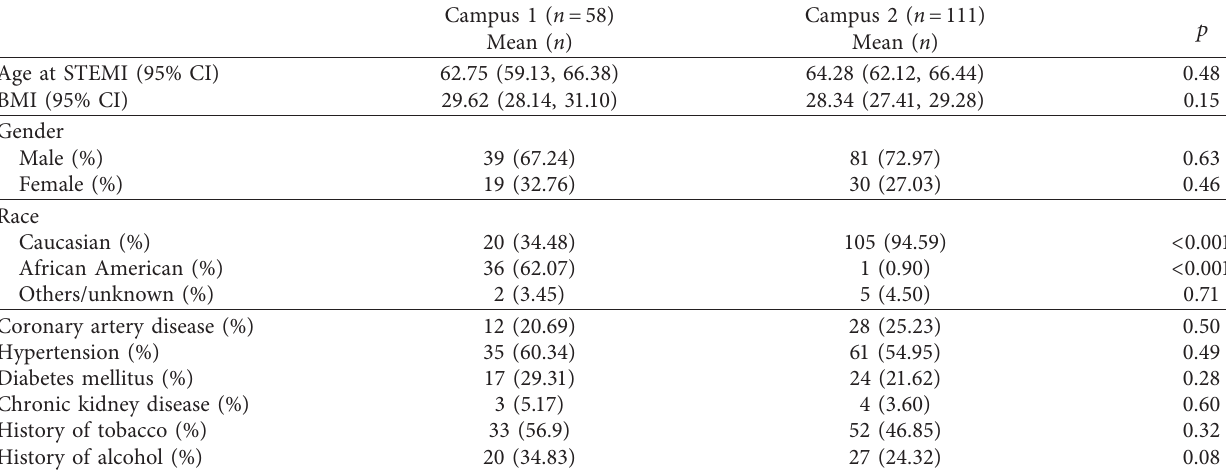
Table 2: Baseline demographic characteristics for Campus 1 compared with Campus 2.